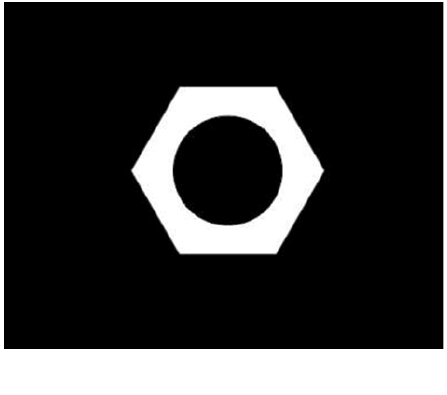
ItwasseenfromFigure3thatSURFhadthehighestfeatureextractionspeedinthecaseofnonoise,taking only 0.245 s; with the increase of noise multiple, the calculation time of the algorithm increased gradually,